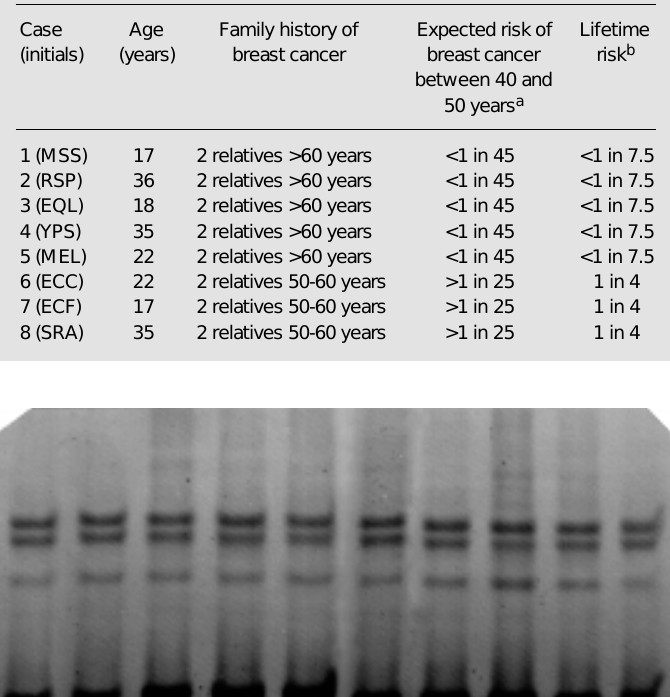
Table 1 - Family history of breast cancer for the women of our sample and assessment of the age-specific risk of breast cancer in women whose relatives developed breast cancer (from Ref. 7).